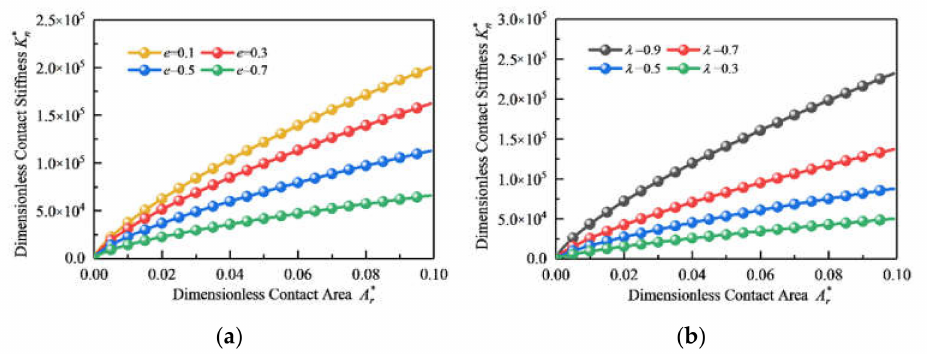
Figure 15. Variations in the dimensionless contact stiffness K ∗ n with the dimensionless contact area A ∗ r : ( a ) different eccentricity e ; ( b ) different contact coefficient λ